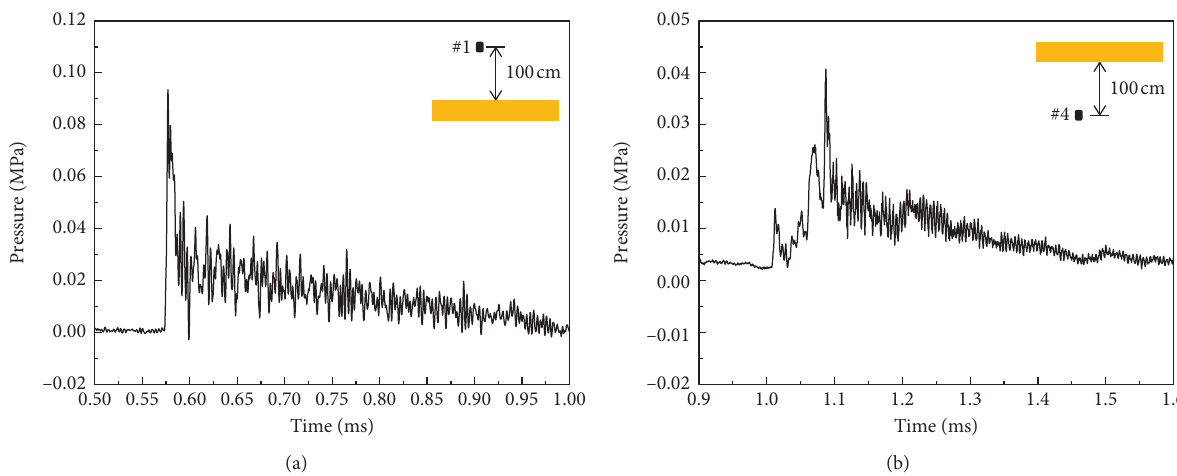
Figure 16: Time history curves of shock wave pressure in slab B1. Air shock wave measured using (a) sensor #1 and (b) sensor #4.